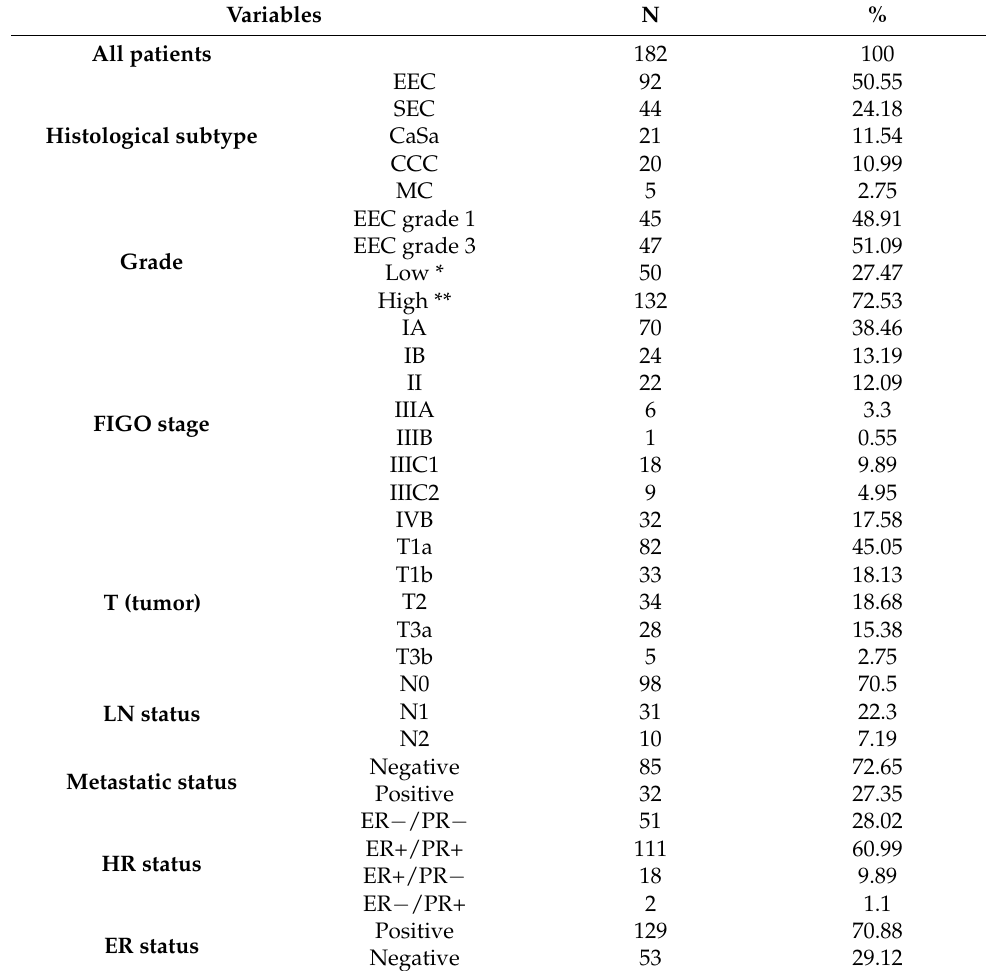
Figure 2. Relative miRNA expression in endometrioid, serous, and rare subtypes of endometrial carcinoma. Differential expression of miR-145-5p of endometrioid endometrial carcinomas grade 1 (EEC G1) and grade 3 (EEC G3) compared to carcinosarcomas (CaSa) and mucinous endometrial carcinoma (MC) ( A ) and miR-143-3p differential expression between EECs and CaSas ( B ). The lengths of the boxes show the interquartile range (IQR), which represents values between the 75th and 25th percentiles. ( ) labels outliers (values more than 1.5 IQRs and less than 3 IQRs from the end of the box). (*) represents (cid:35) values greater than three IQRs. The horizontal line depicts the median. Statistical significance is regarded as p < 0.05. Table 4. Clinical characteristics of endometrial cancer